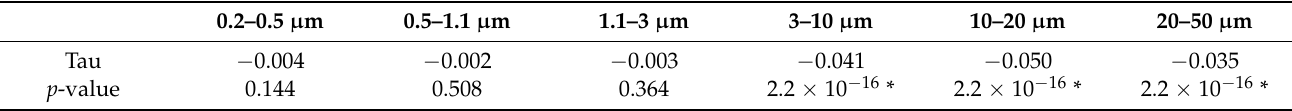
Table 3. Kendall’s rank correlation results between precipitation and PM in three locations between 2013 and 2019.